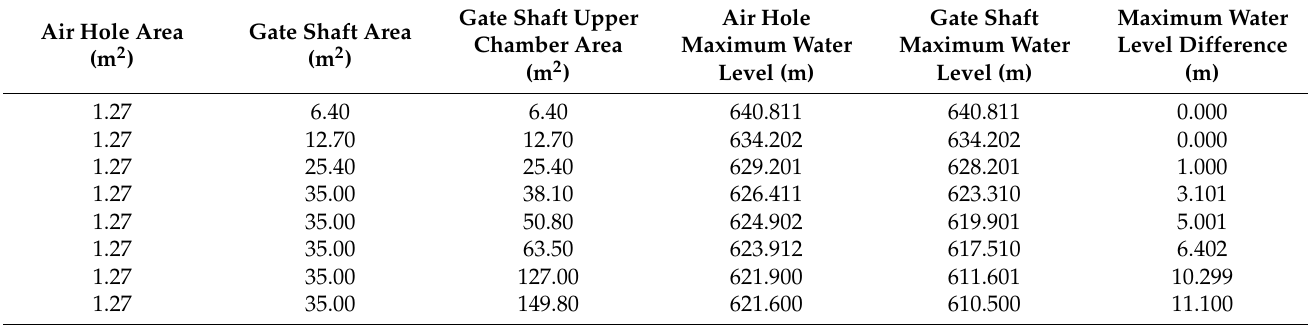
Table 5. Maximum water level of the gate shaft and air hole (increasing upper chamber